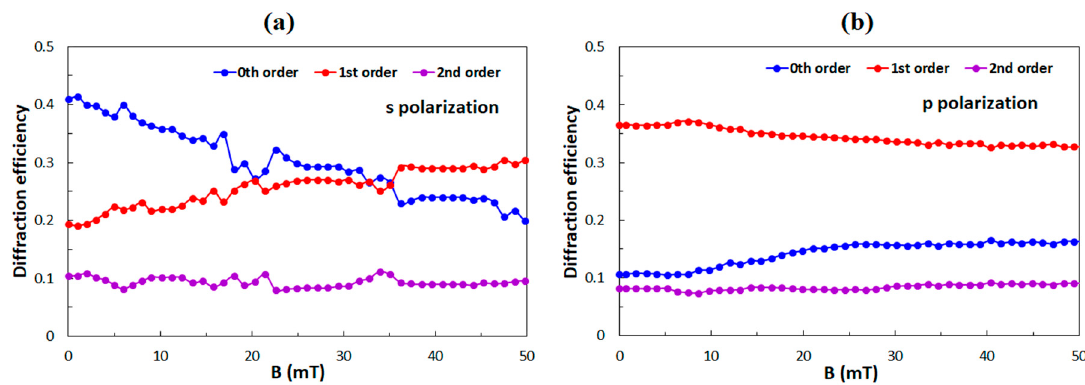
Figure 4. Experimental data of diffraction efficiencies of the 0th, 1st, and 2nd diffraction orders as a function of the applied external magnetic field for ( a ) the s-polarized and ( b ) for the p-polarized incident beam.